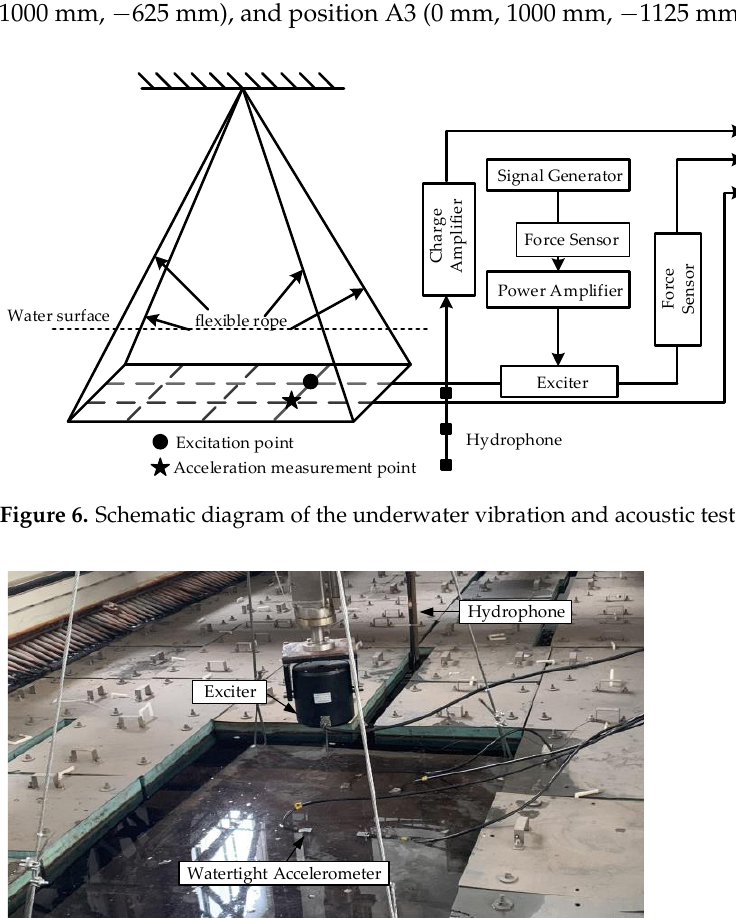
Figure 8. The layout of the underwater vibration and acoustic radiation measuring points. ( a ) The layout of vibration measurement points; ( b ) the layout of acoustic radiation measurement points.